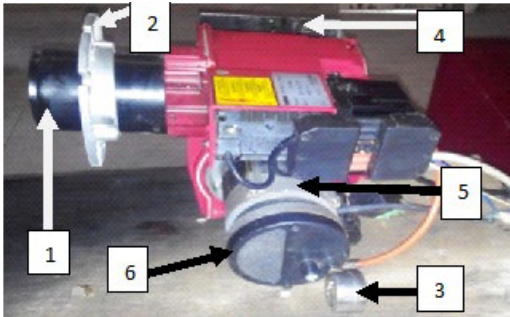
Fig. 1. Atomizing swirl waste oil burner. 1 – Blast tube; 2 – Flange; 3 – Pressure gauge; 4 – Oil preheating tank; 5 – Motor; 6 – Air